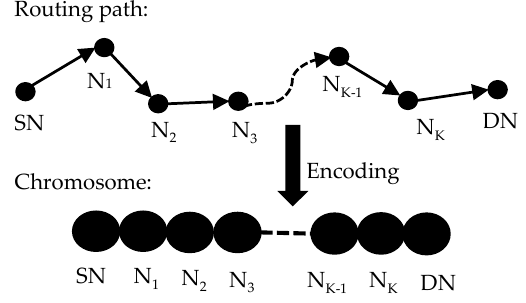
Figure 2. The process of encoding.